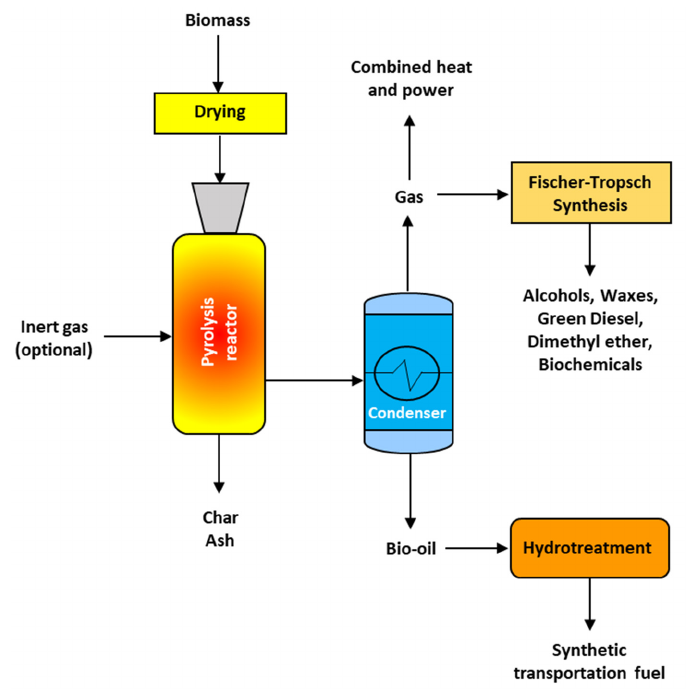
Figure 2. Typical process representation of pyrolysis of biomass. Table 3. Summary of notable works on pyrolysis of waste